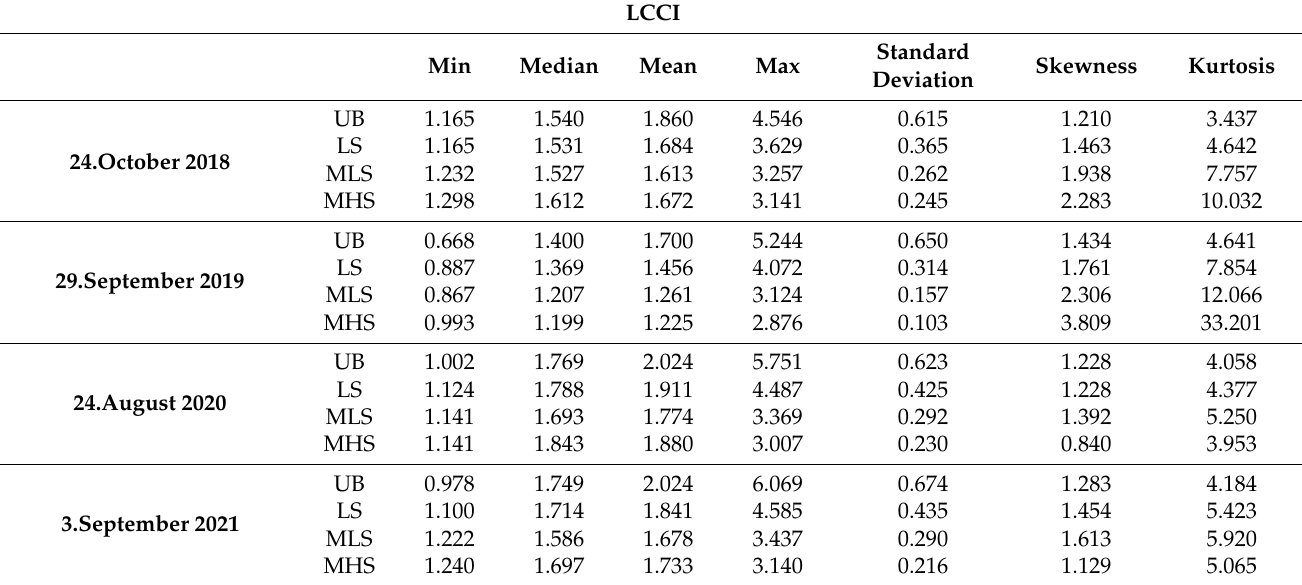
Table A2. Statistics of pre- and post-fire LCCI in different fire severity classes at the El Saco basin. LCCI Standard Skewness Kurtosis Min Median Mean Max Deviation